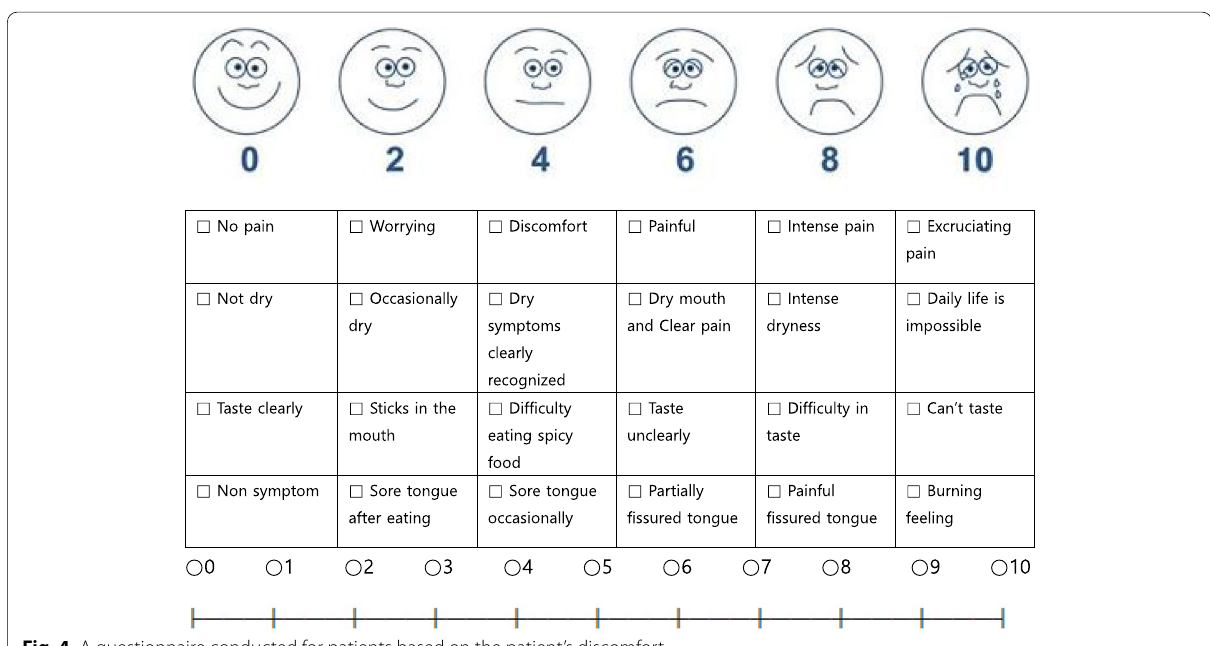
Fig. 4 A questionnaire conducted for patients based on the patient’s discomfort